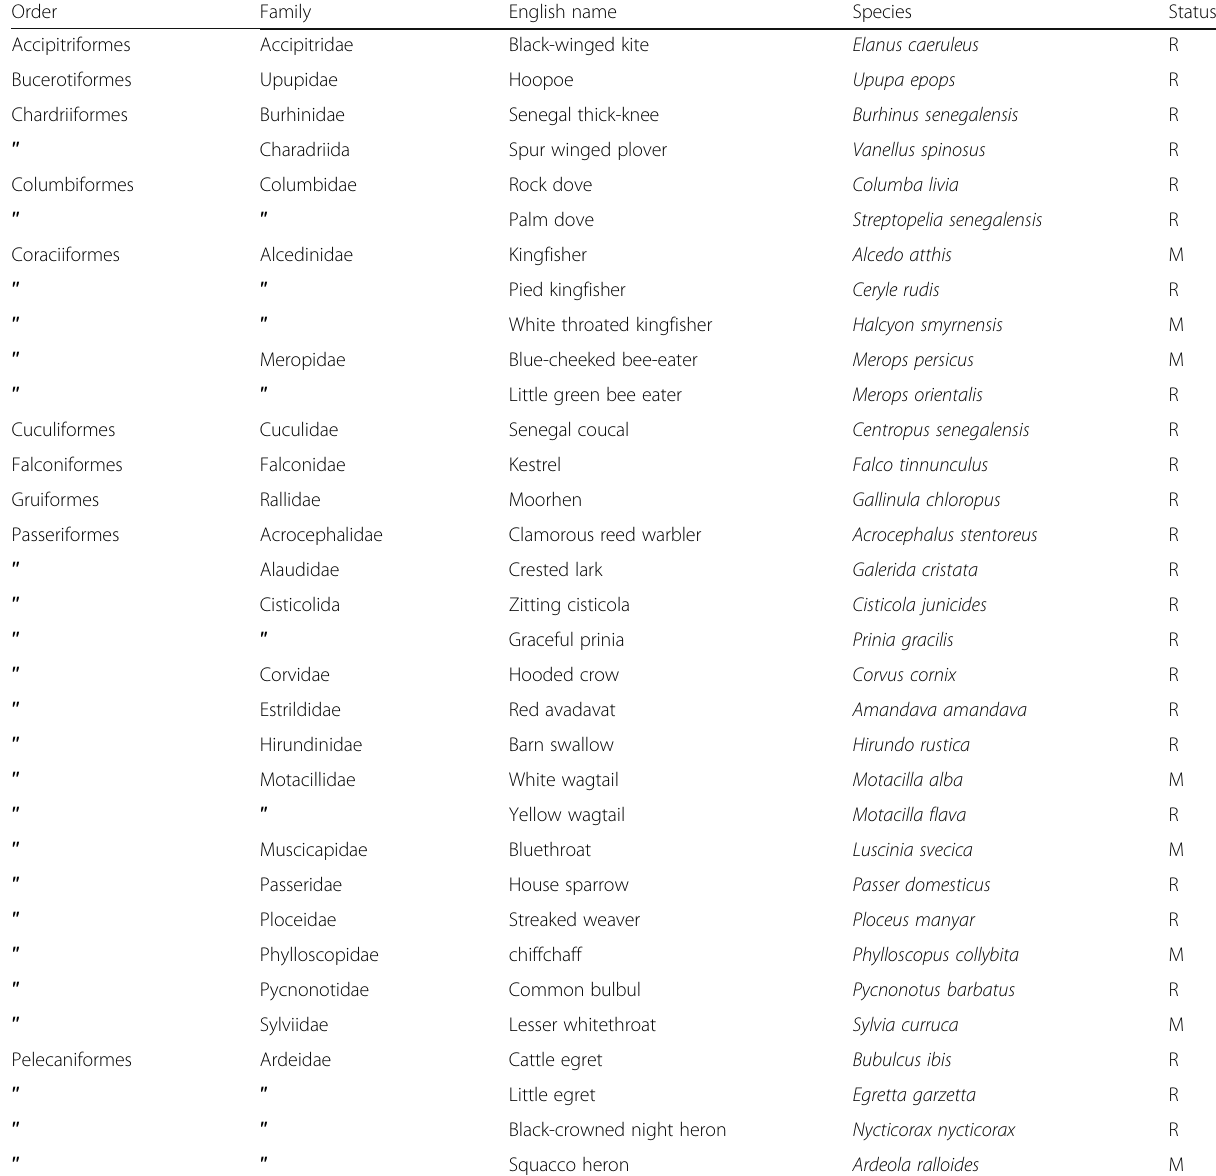
Table 1 Wild birds species recorded from the two districts; Zagazig and Hehia, at Sharkia governorate Order Family English name